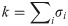
Decomposing retinal population responses into modes.(A) Example spike raster from 5 sec of training data (N = 152 cells). Each column represents the population spiking pattern as a binary word, {σi(t)}, defined over a 20 ms time bin. Colored bands indicate periods of time during which a particular mode was active. (B) Population spike count. Note that activity is characterized by bouts of highly correlated population spiking punctuated by periods of relative quiescence. (C) Time-varying probability, P, of each mode, given all the observed data. P is quantified by fitting the model described in Fig 2 and in the main text. Modes are sorted top-to-bottom by decreasing probability. Note that periods of high population spike count (k=∑iσi) generally corresponded to well-defined modes (P of one mode near 1, with sharp temporal transitions between modes), while periods when P was smeared across several modes coincided with the population being more quiescent (grey band in B).